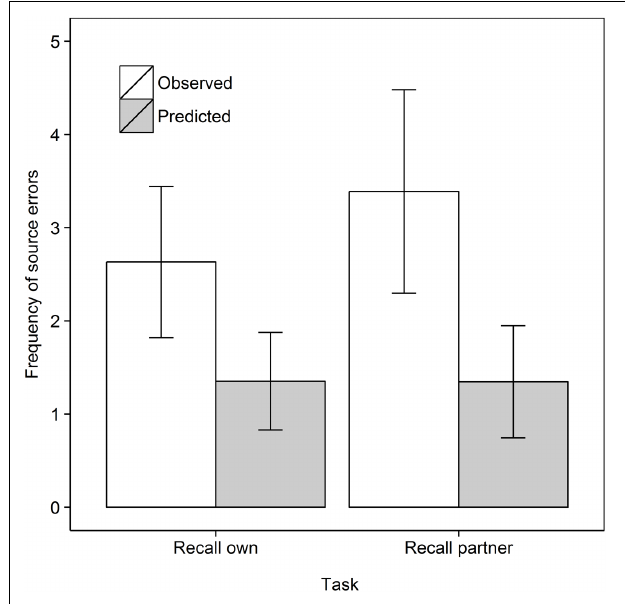
FIGURE 3 | Frequency of observed and predicted source errors in the Recall own and Recall partner task in Experiment 2 for the no concurrent load condition. The error bars are 95% within-subjects confidence